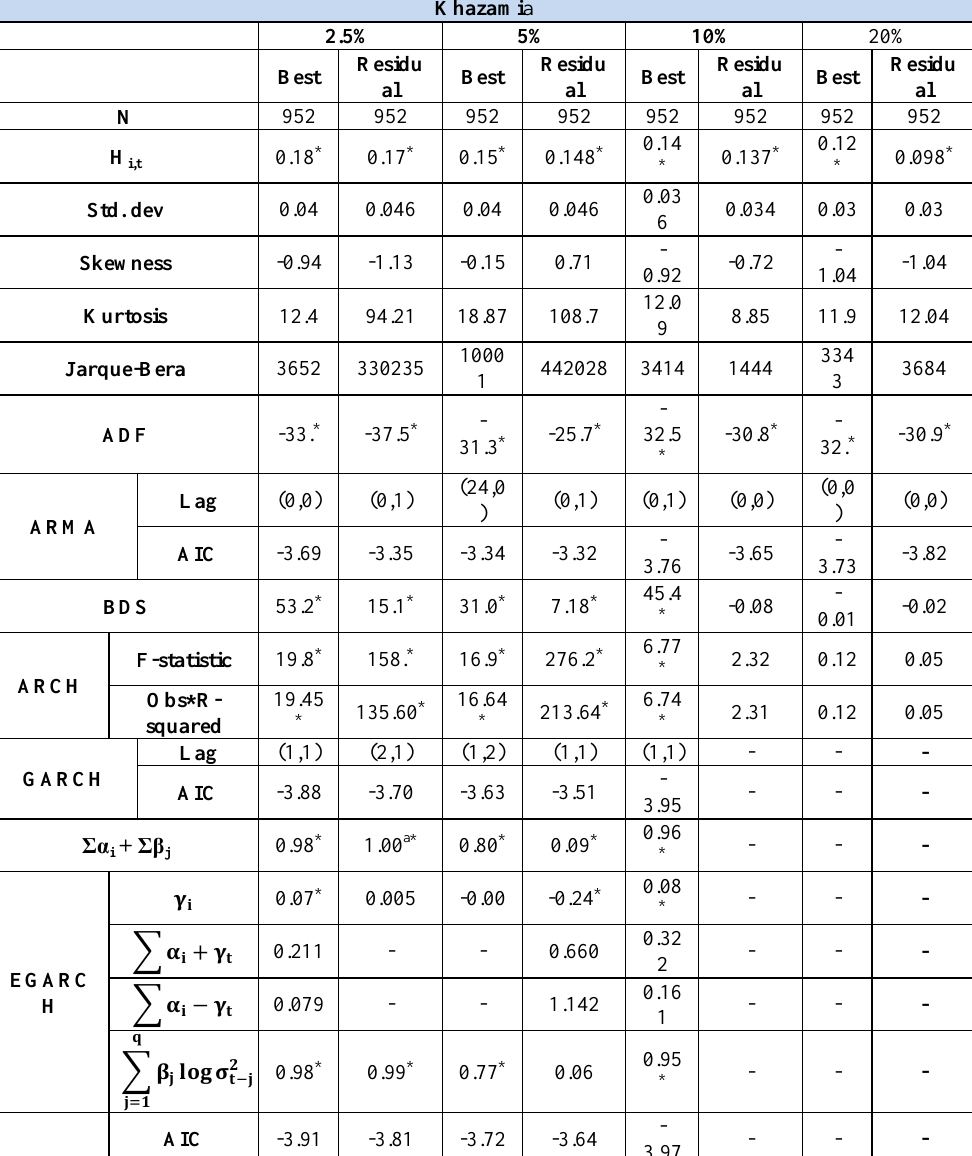
Table 3. Econometric statistics for Khazamia price series estimated by